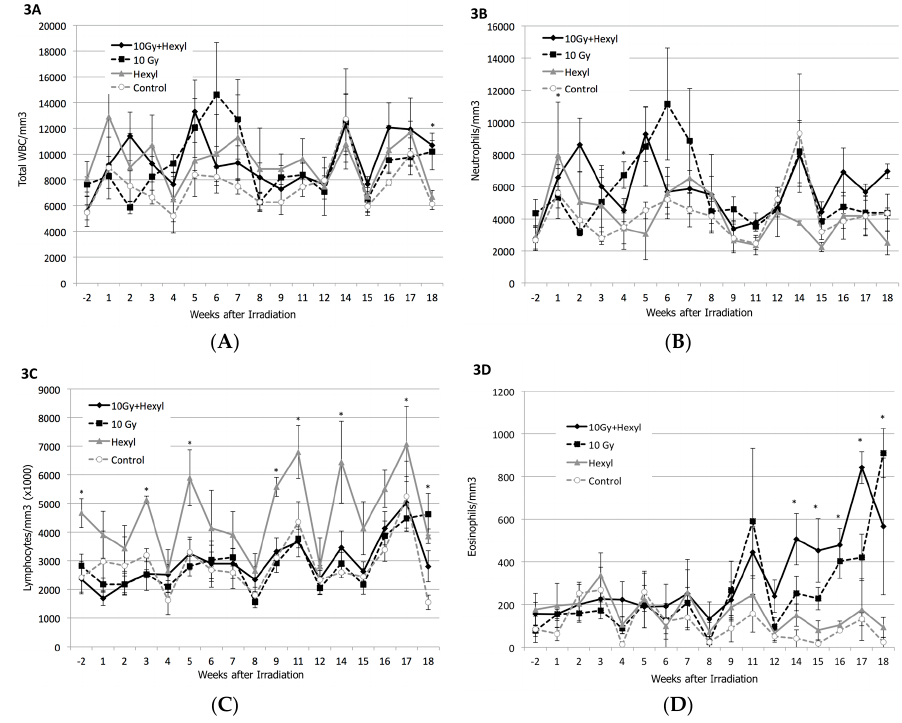
Figure 3. White blood cell changes. ( A ) Overall white blood cell count; ( B ) neutrophil count; ( C ) lymphocyte count; and ( D ) eosinophil count. White blood cell counts (primarily neutrophils) were elevated in irradiated animals 6 weeks after irradiation, coincident with the onset of clinical signs and computed tomography (CT) abnormalities. Lymphocyte counts were highest in non-irradiated